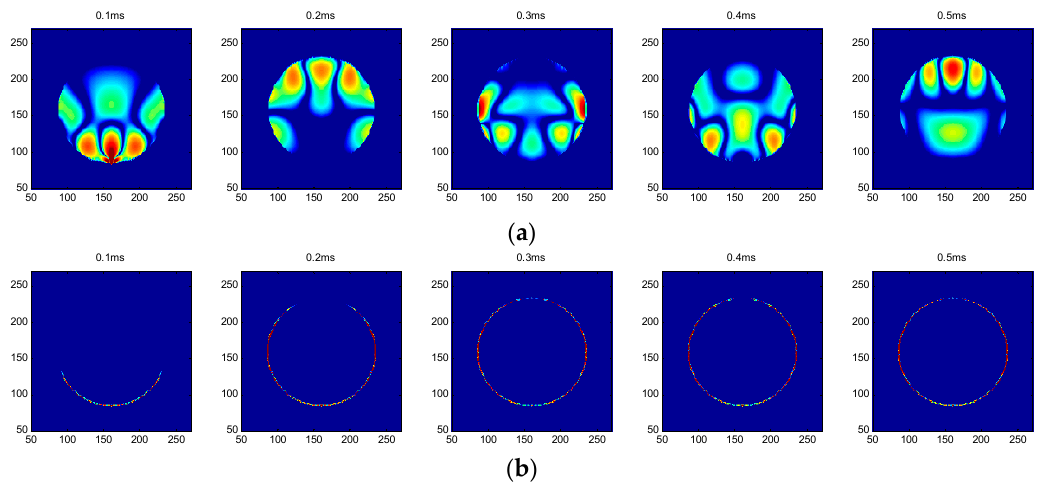
Figure 2. Snapshots excited by R3: ( a ) a full concrete infill and ( b ) an empty concrete infill.